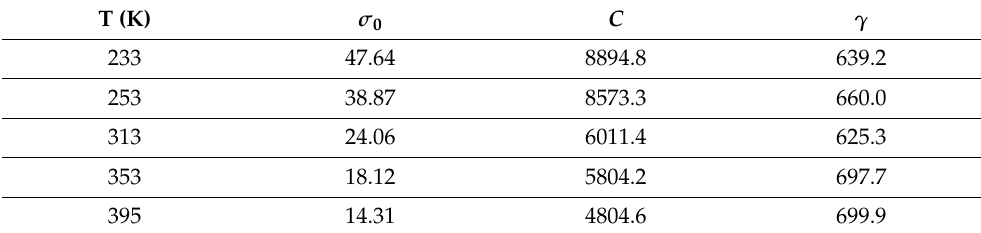
Table 4. Parameters for the Chaboche